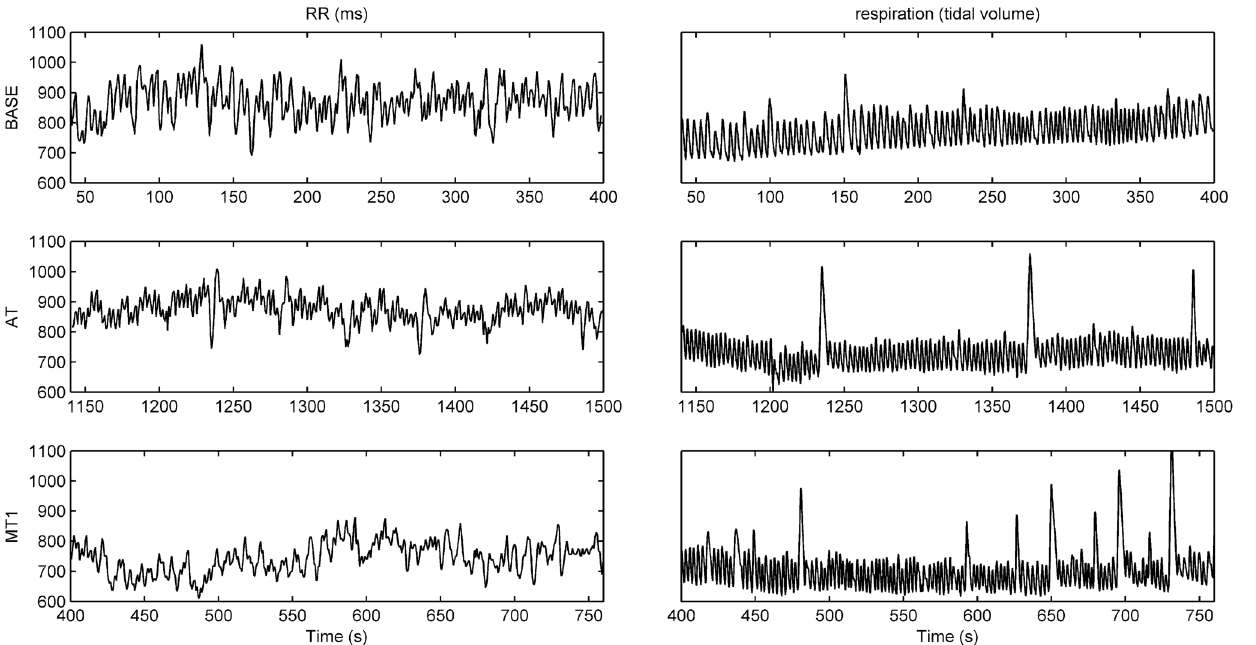
Fig 1. RR interval series and respiratory signals during baseline (BASE), sustained attention (AT) and the first mental stress task (MT1).